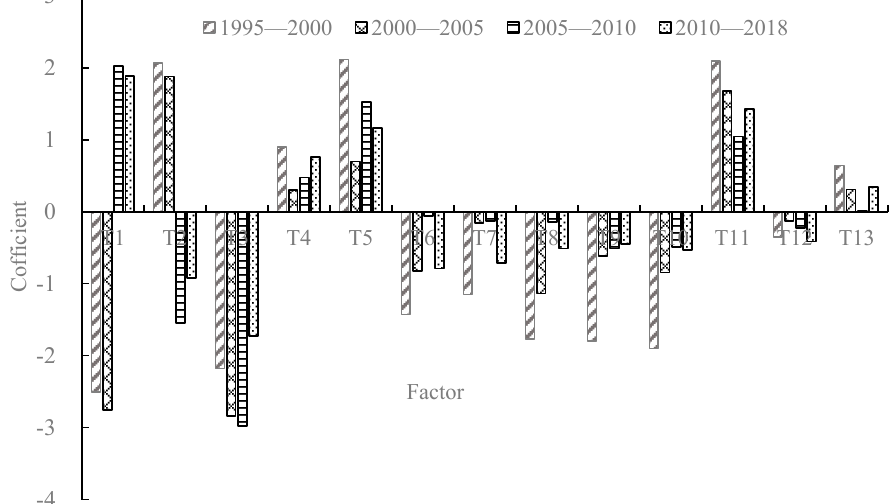
Figure 8. Time series distribution of factor average coefficient change in each period. (1) Judgment of the whole area core factors: From 1995 to 2018, the conversion of gully farmland of the study area was mainly based on the population and GDP per land area of socio ‐ economic factors. The slope of natural factors and the distance from the water area of neighboring factors were the core influencing factors. Among them, the population factor and slope factor had always been in a dominant position, and they were the main driving factors for the conversion of gully farmland. The intensity of population was higher than that of the slope during 1995–2000 and 2010–2018. The driving effect of the slope on gully farmland conversion during 2000–2005 and 2005–2010 was obvious. (2) Temporal evolution of the whole area core factors: Slope was the most influential factor in the conversion of gully farmland. The intensity of its effect was a fluctuating and rising trend from the beginning of 1995 to 2010, and the intensity was the greatest in 2010. The relationship between population and the transformation of gully farmland was neg ‐ atively correlated in the first 10 years. The overall effect of the population on the expansion and transformation of gully farmland showed a downward trend. Slope aspect and topo ‐ graphic relief factors were positively correlated with gully farmland shrinkage. From the whole study period, the intensity of aspect effect intensity first decreased and then in ‐ creased, and remained flat. The influence of traffic neighborhood factors generally showed a slight decrease. The gully was negatively correlated with the transformation of farmland shrinkage. The distance from the center of the county was negatively correlated with the shrinkage of gully farmland. The intensity of the impact first decreased and then increased, showing an overall increasing trend. There was a positive correlation between the distance from the water area and the center of town and the change of gully farmland shrinkage in Yan’an City, and the intensity of these factors was gradually declining. At the county level, it was the basis of regional differentiation governance to identify the driving force of gully farmland contraction. In order to identify the difference in the conversion drive of the gully farmland between the counties and determine the time series change of the drive strength, the incidence of factors driving the transformation of gully farmland contraction was compared among the counties as follows (Figure 9). Among these, the positively related variables were directly taken as logarithm exp (g), and nega ‐ tively related variables were converted into positive cumulative values through the factor of 1/exp (g).